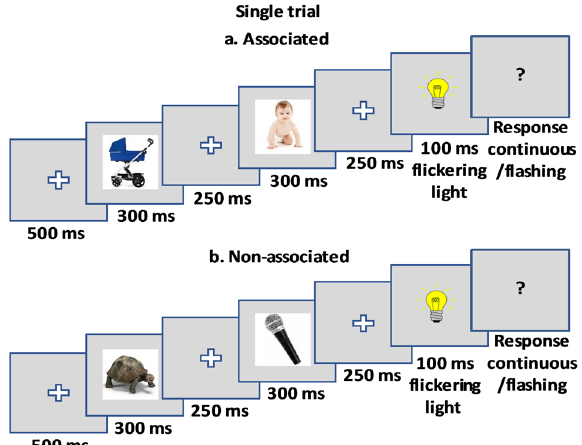
Fig. 5 Illustration of the paradigm. The experiment was divided into two blocks. a Associated block. b Non-associated block. Each trial consisted of seven presentations. Participants required to determine whether the fl ickering light is continuous or